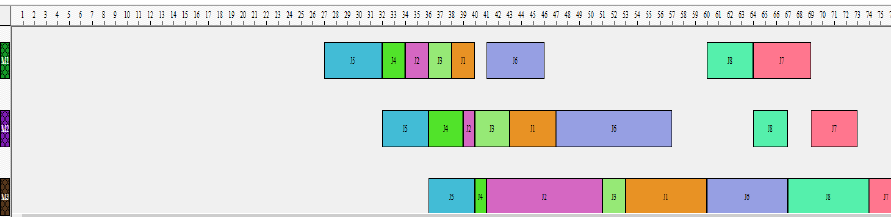
Figure 7. Gantt chart of the best solution with eight jobs by GA.